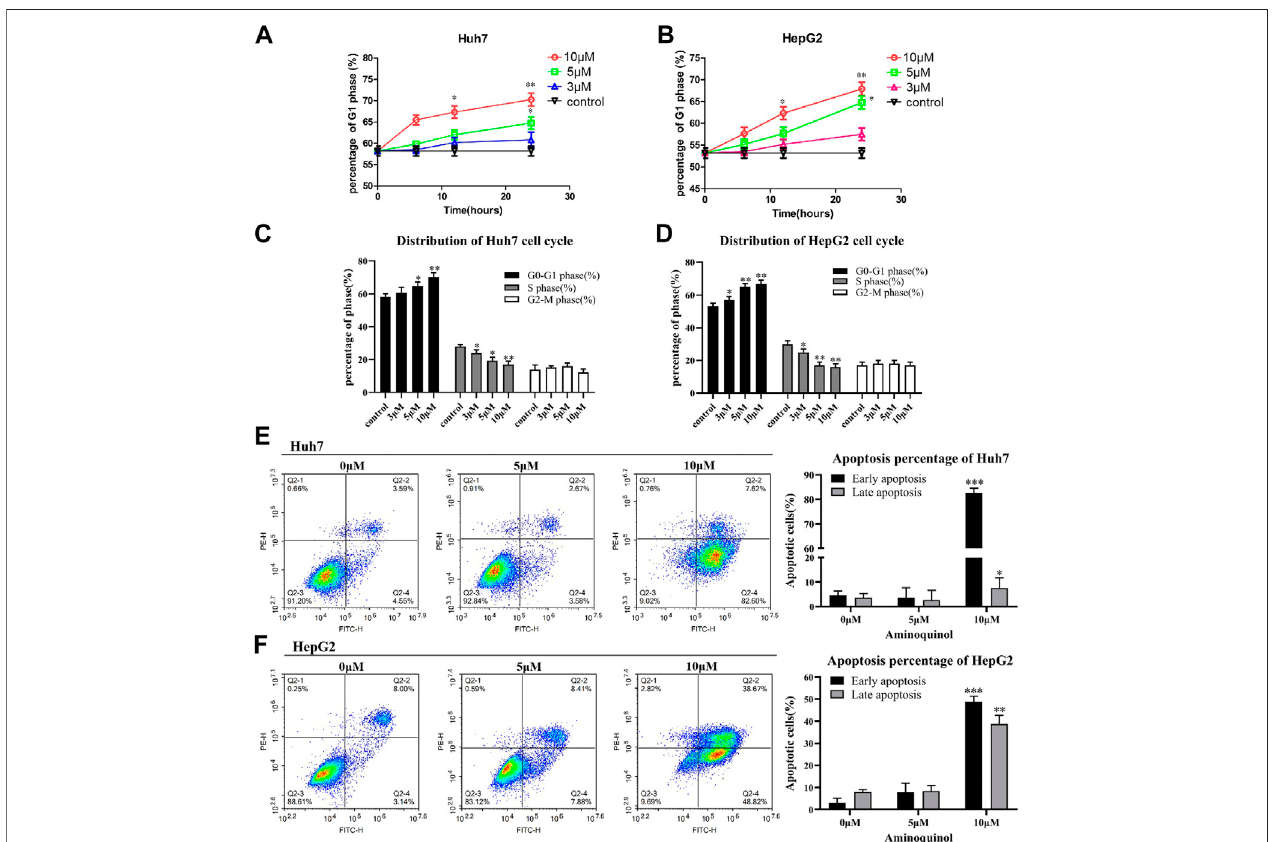
FIGURE 2 | Aminoquinol treatment caused cell cycle G1 arrest and induced apoptosis in Huh7 and HepG2 cells (A) Aminoquinol (3, 10 and 30 μ M) treatment induced the accumulation of cells in G1 phase in a dose-and time-dependent manner in Huh7 and (B) HepG2 cells (C) At 24 h after treatment, aminoquinol signi fi cantly ( p < 0.05)increasedcellpopulationsintheG1phaseanddecreasedthecellpopulationsinS-phaseinHuh7and (D) HepG2cells (E) At48 haftertreatment.aminoquinol (10 μ M)signi fi cantlyincreasedthepercentageofearlyandlateapoptosisinHuh7and (F) HepG2cellsascomparedtothecontrol( p < 0.05),*,**indicatesigni fi cant difference at p < 0.05, p < 0.01,